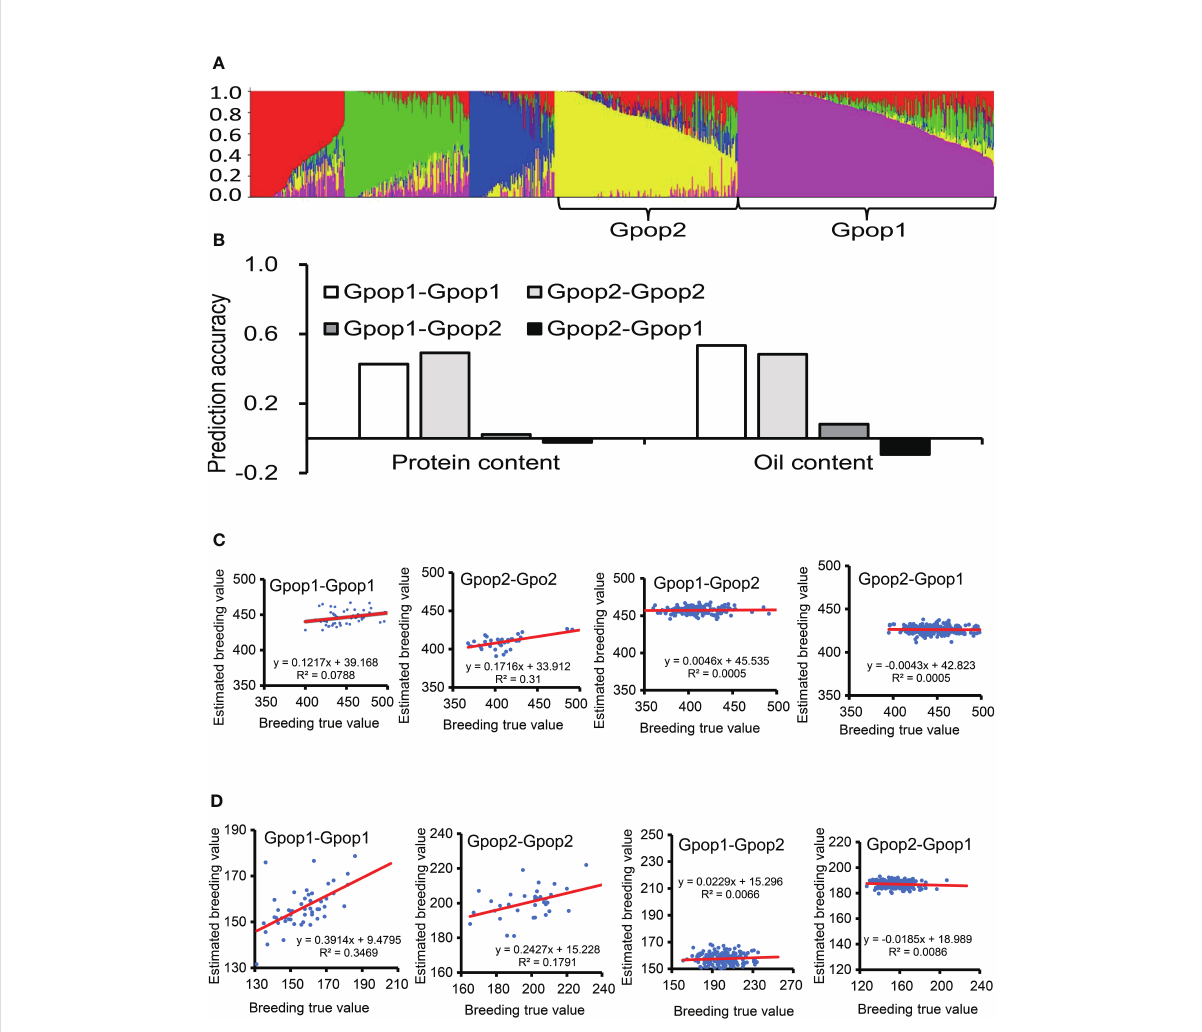
FIGURE 3 The effect of genetic similarity between the training population and prediction population. The prediction accuracies of RR-BLUP for protein and oil content among soybean germplasms grown at Urbana, IL in 2001 and 2002 (B) , when the training population and prediction population were selected according to genetic structure (A) . (C) Scatter plot of protein content, abscissa for breeding true value, ordinate for estimated breeding value, the red line is the trend line. (D) Scatter plot of oil